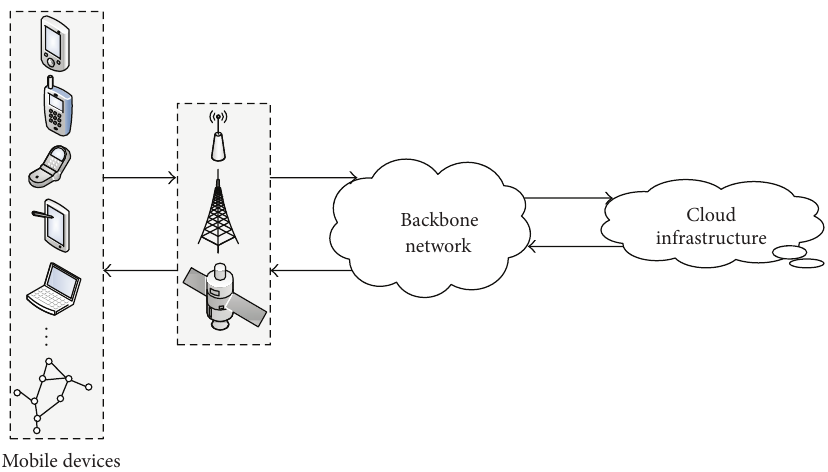
Figure 1: The architecture that uses the remote cloud infrastructure.